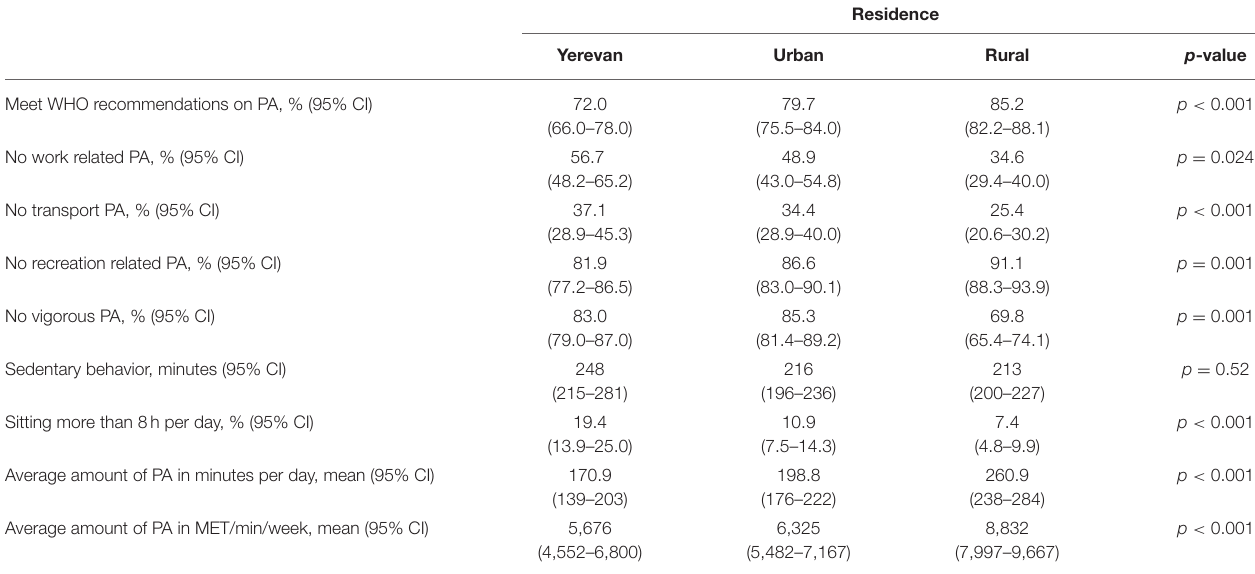
TABLE 4 | Indicators of physical activity and sedentary behavior for residence.